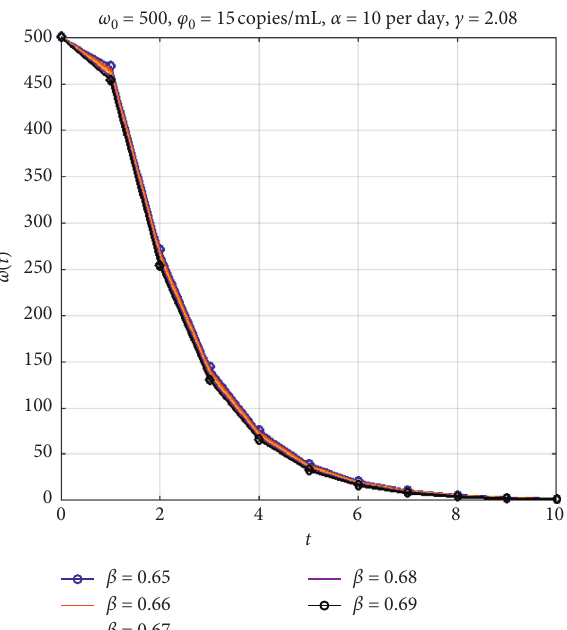
Figure 2: Concentration of viral particles in plasma φ for different values of time t and initial concentration of viral particles in plasma φ with rate constant of viral particle clearance c � 2 . 08 day − 1 .